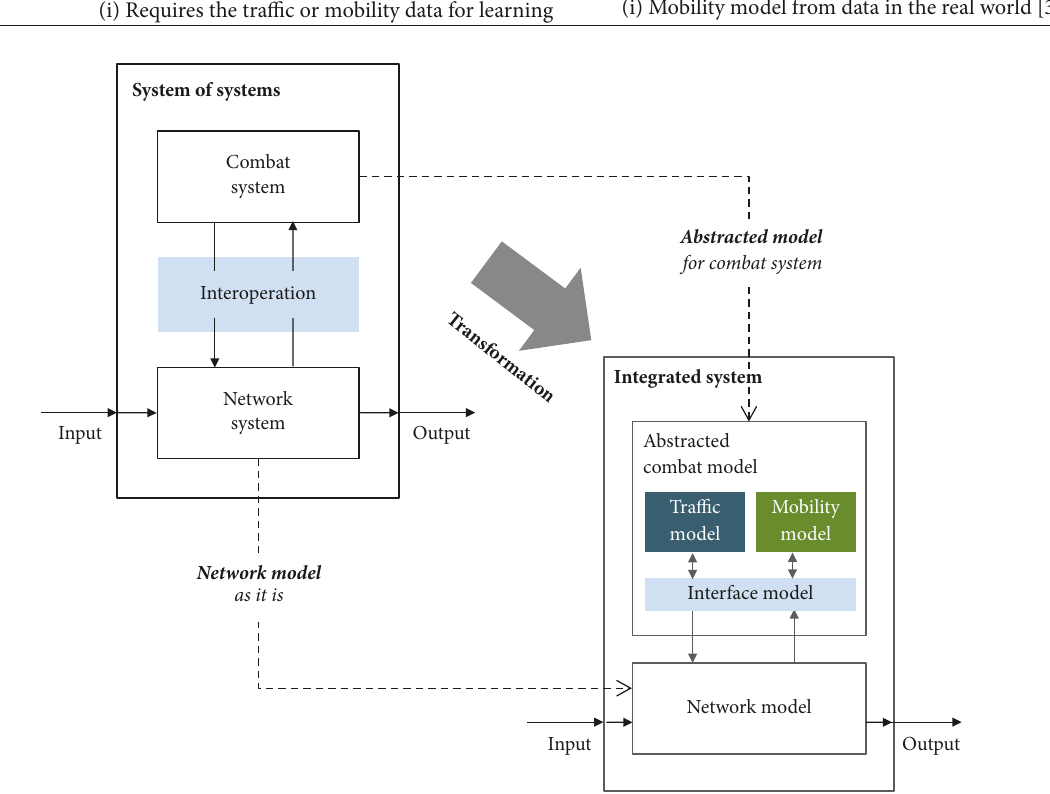
Figure 3: Transformation of the SoS into the integrated system for NCW